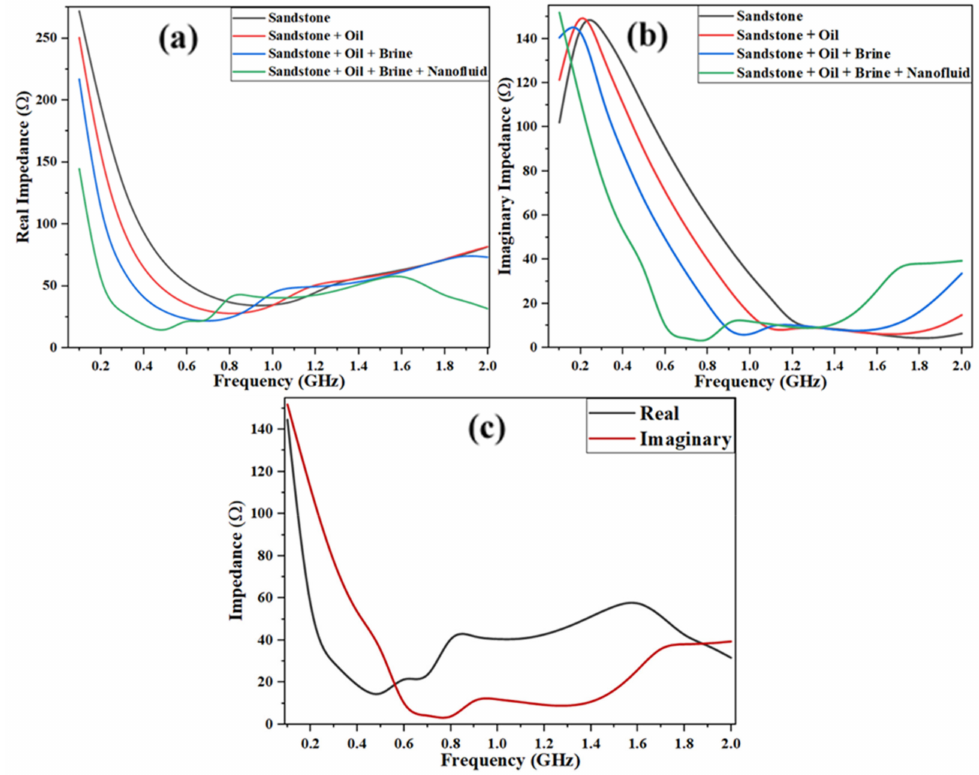
Figure 7. Input impedance of the antenna in sandstone medium at di ff erent saturations; ( a ) real impedance, ( b ) the imaginary part and ( c ) real and imaginary impedance in sandstone containing oil, brine and